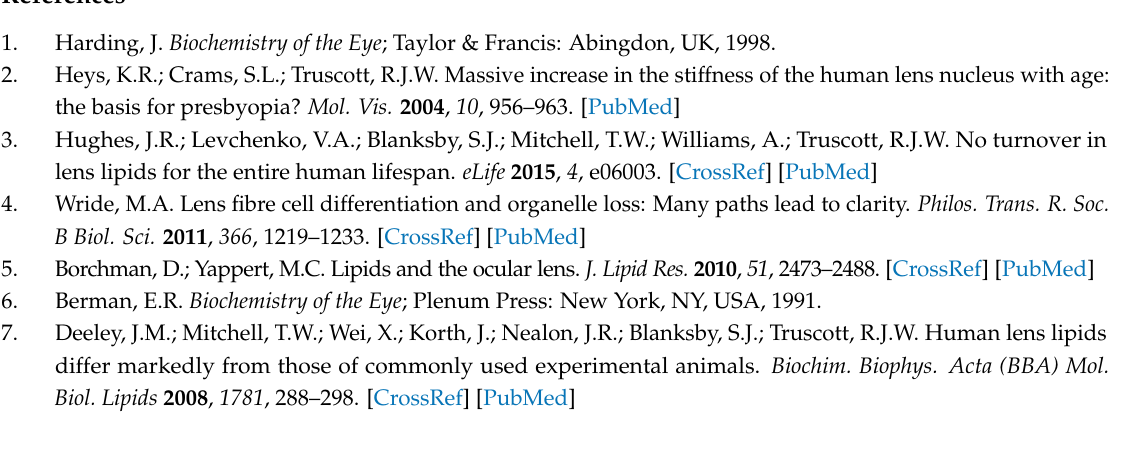
Figure S1: Distribution of all PE species in a 51- and 67-year-old human lens, Figure S2: Distribution of all PS species in a 51- and 67-year-old human lens, Table S1: List of lipids detected in [M − H] − with m / z measured experimentally and expected theoretical m / z